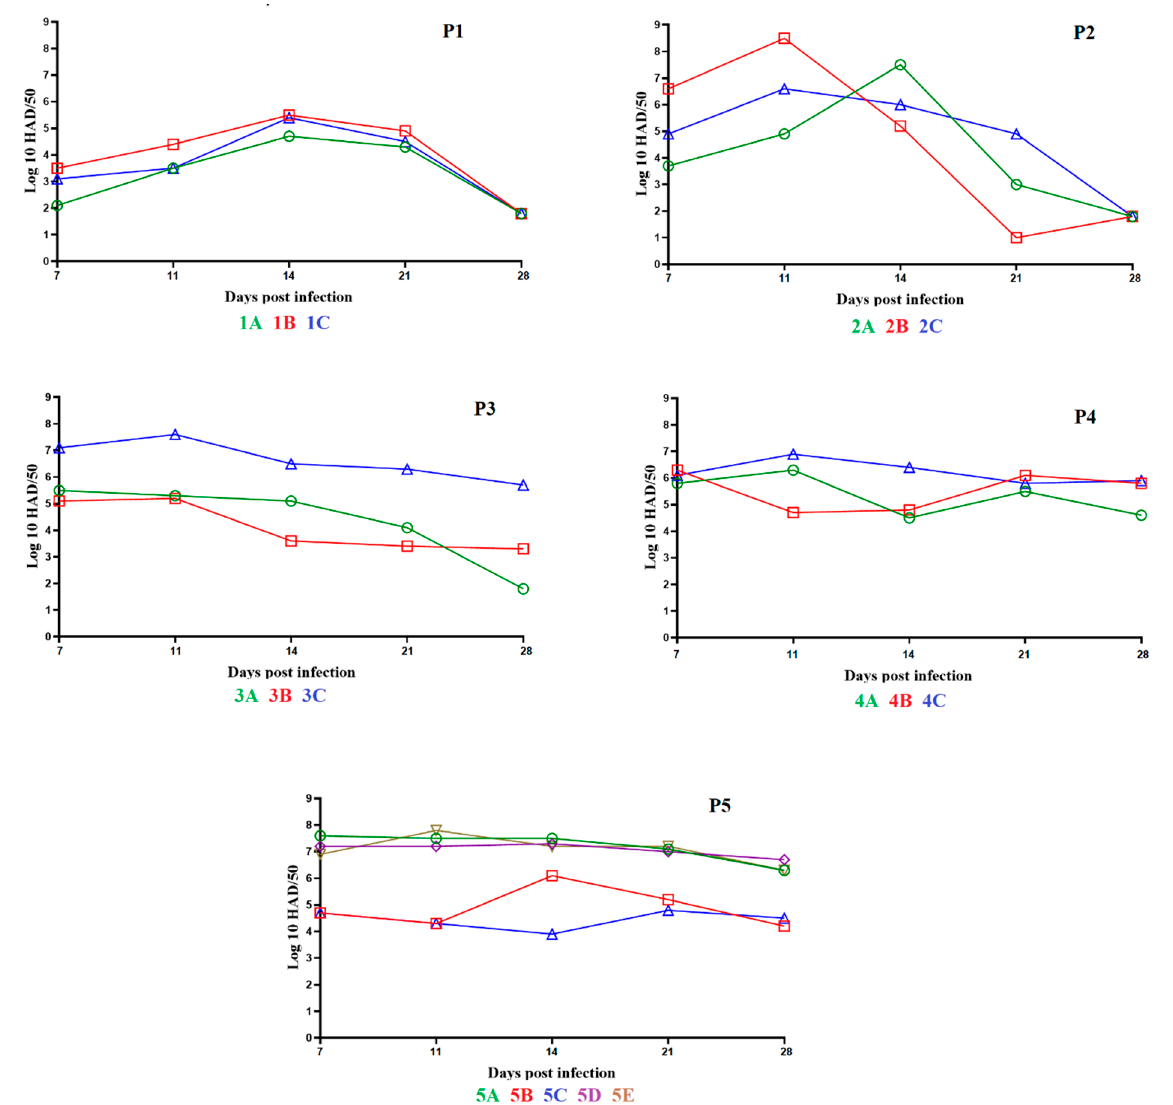
Figure 3. Evolution of viremia titers in animals IM inoculated with ASFV-G- ∆ I177L during 5 consecutive passages (panels P1 to P5, respectively). Data are presented as individual values of virus titers (expressed as HAD 50 /mL) for each of the inoculated animals in each of the different groups.